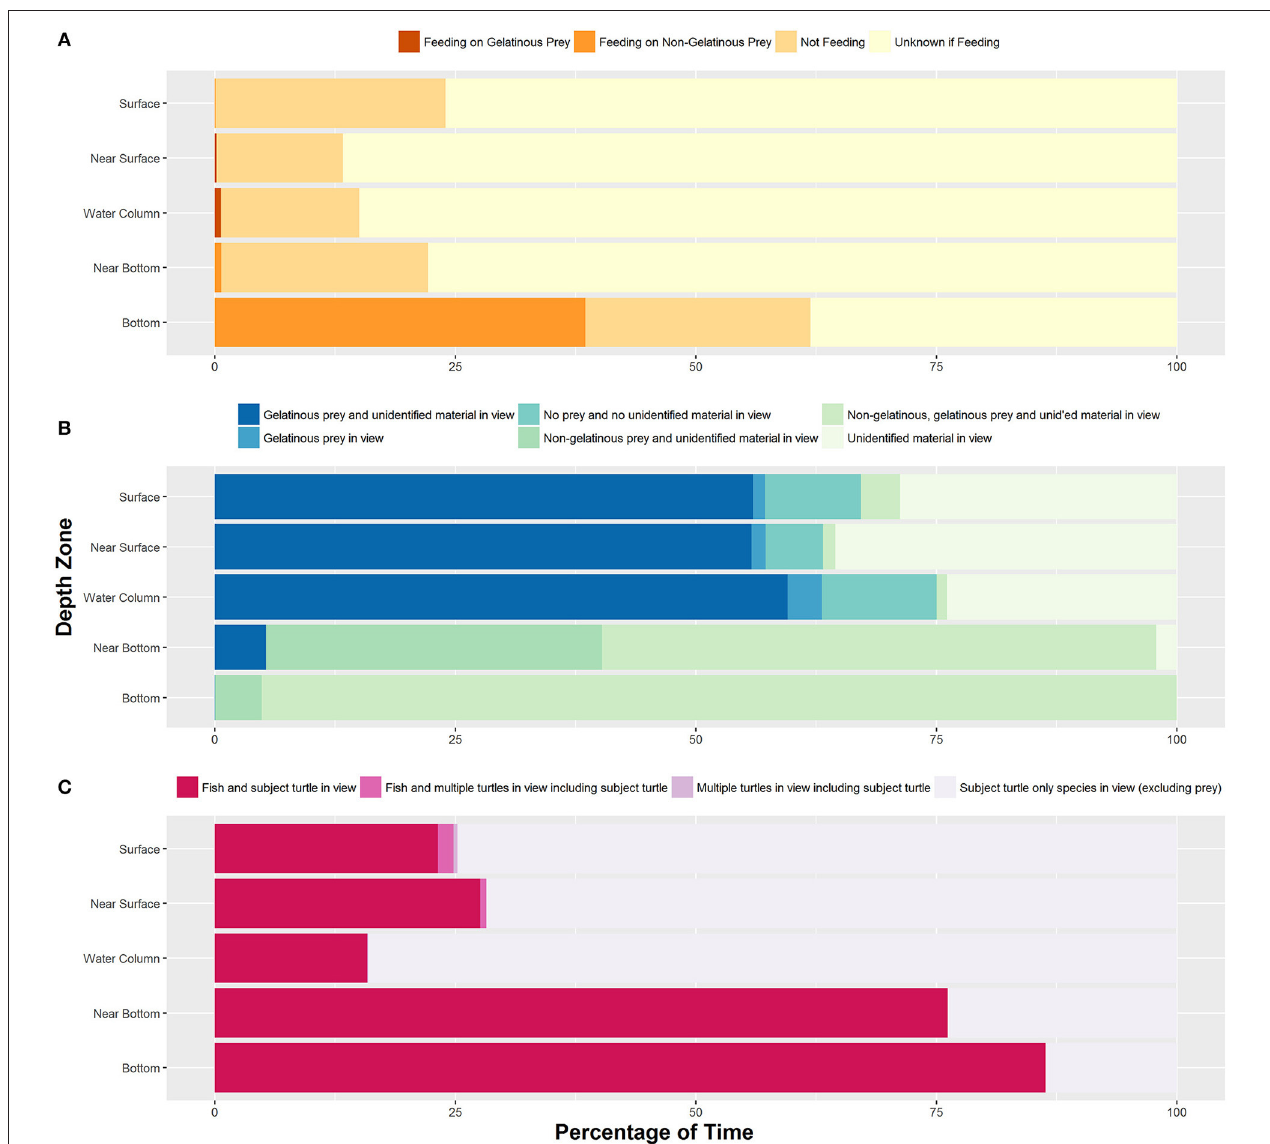
FIGURE 1 | (A) Percentage of time all turtles ( n = 73) exhibited each type of feeding behavior within each depth zone. (B) Percentage of time each prey species category was identified in each depth zone. (C) Percentage of time all turtles experienced each type of inter-/intra-species interaction within each depth zone. Sample sizes for each behavior can be found in Supplementary Table